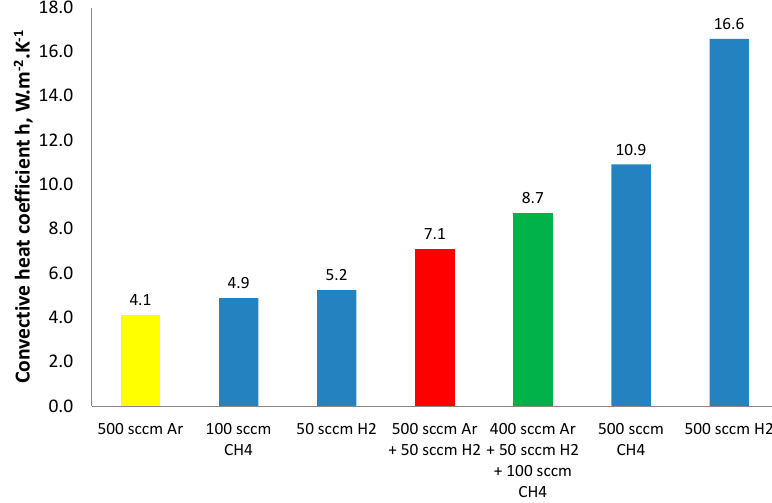
Figure 3. Effect of the gas composition and inlet flowrate on the convective heat transfer around a copper foil.